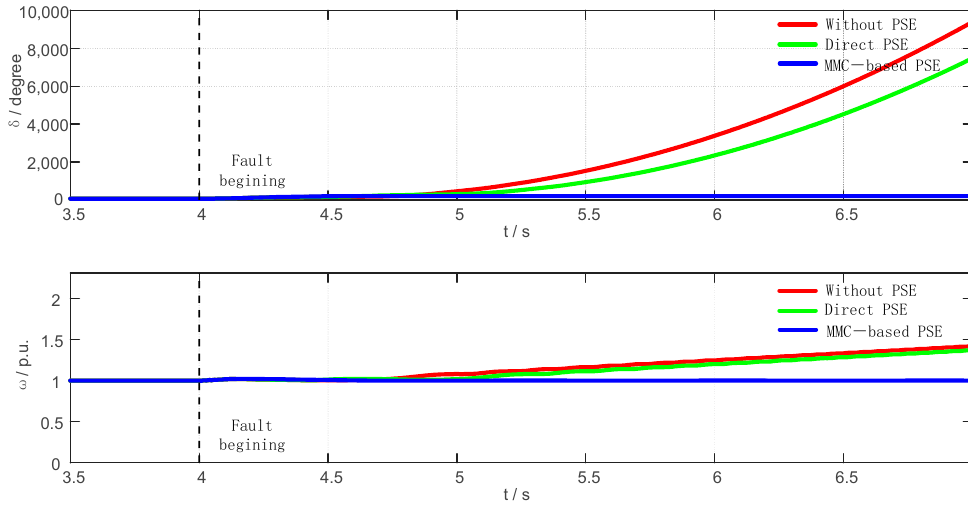
Figure 17. Power angle and speed of the